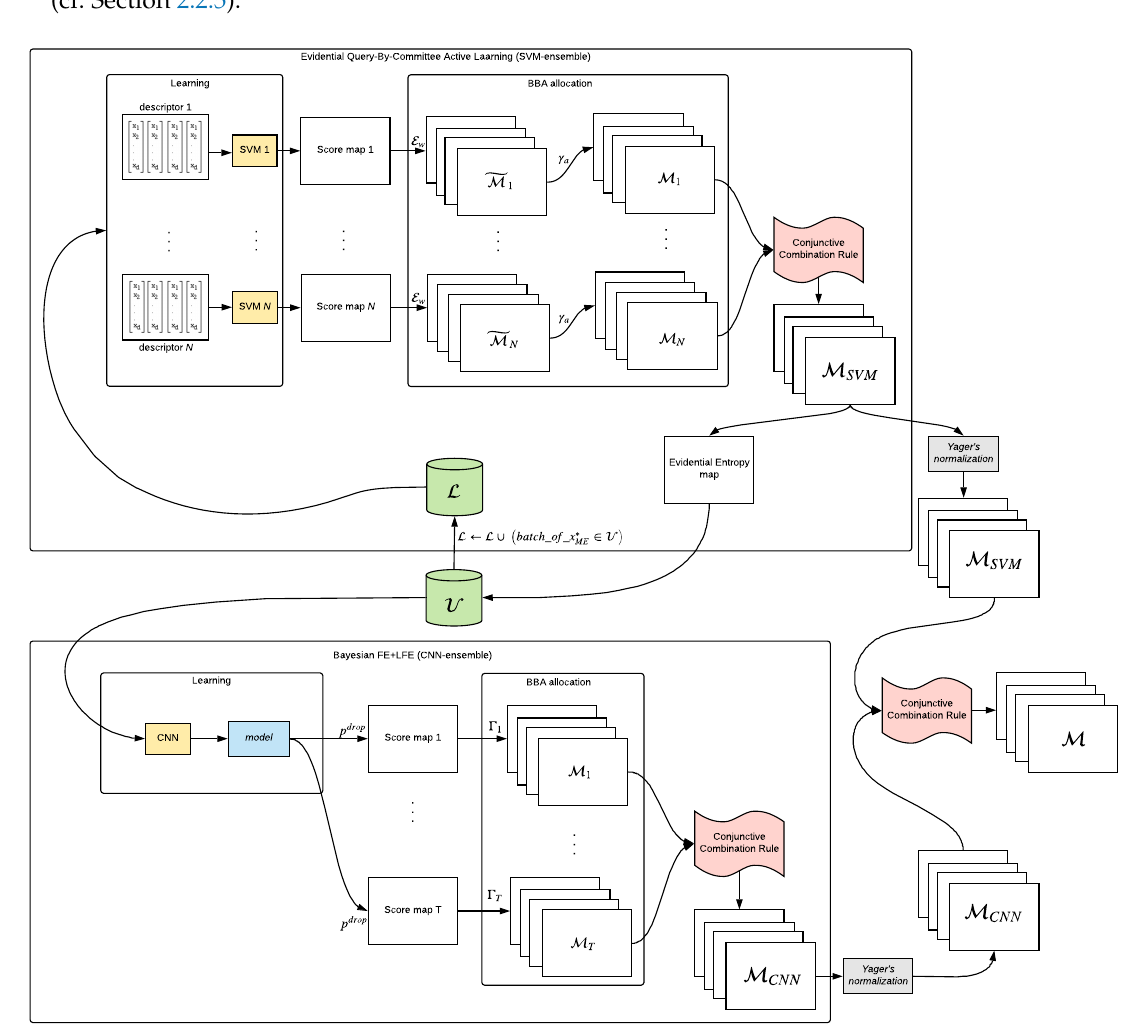
Figure 3. Proposed evidential Multiple Classifier System